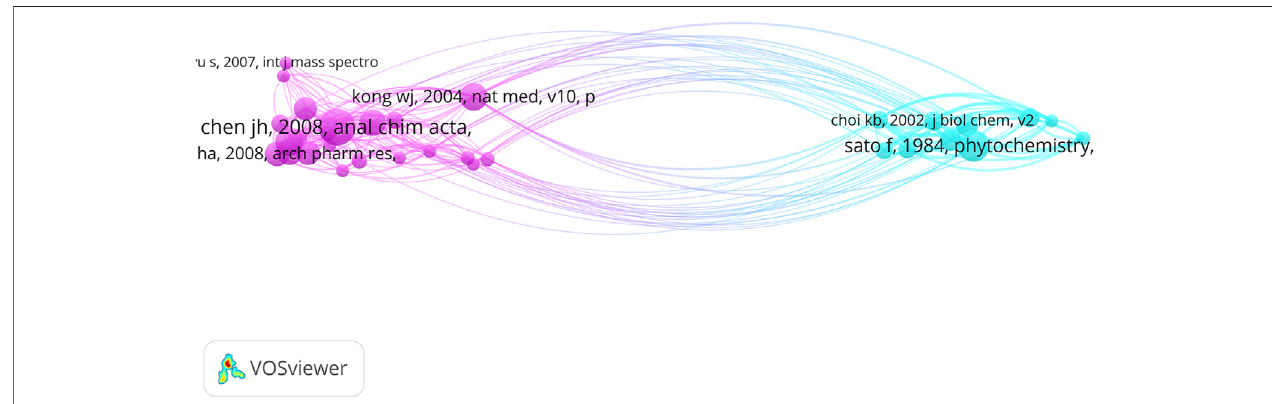
FIGURE 10 | Network map of references co-citation of Coptis